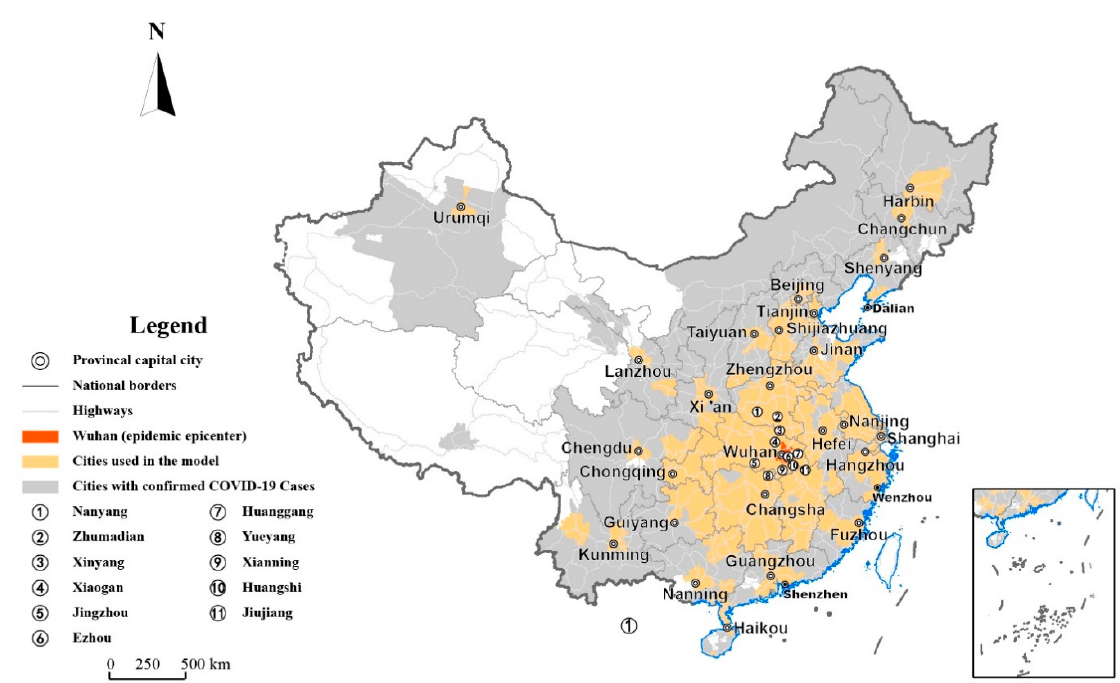
Figure 1. The geographic location of the cities involved in this study.